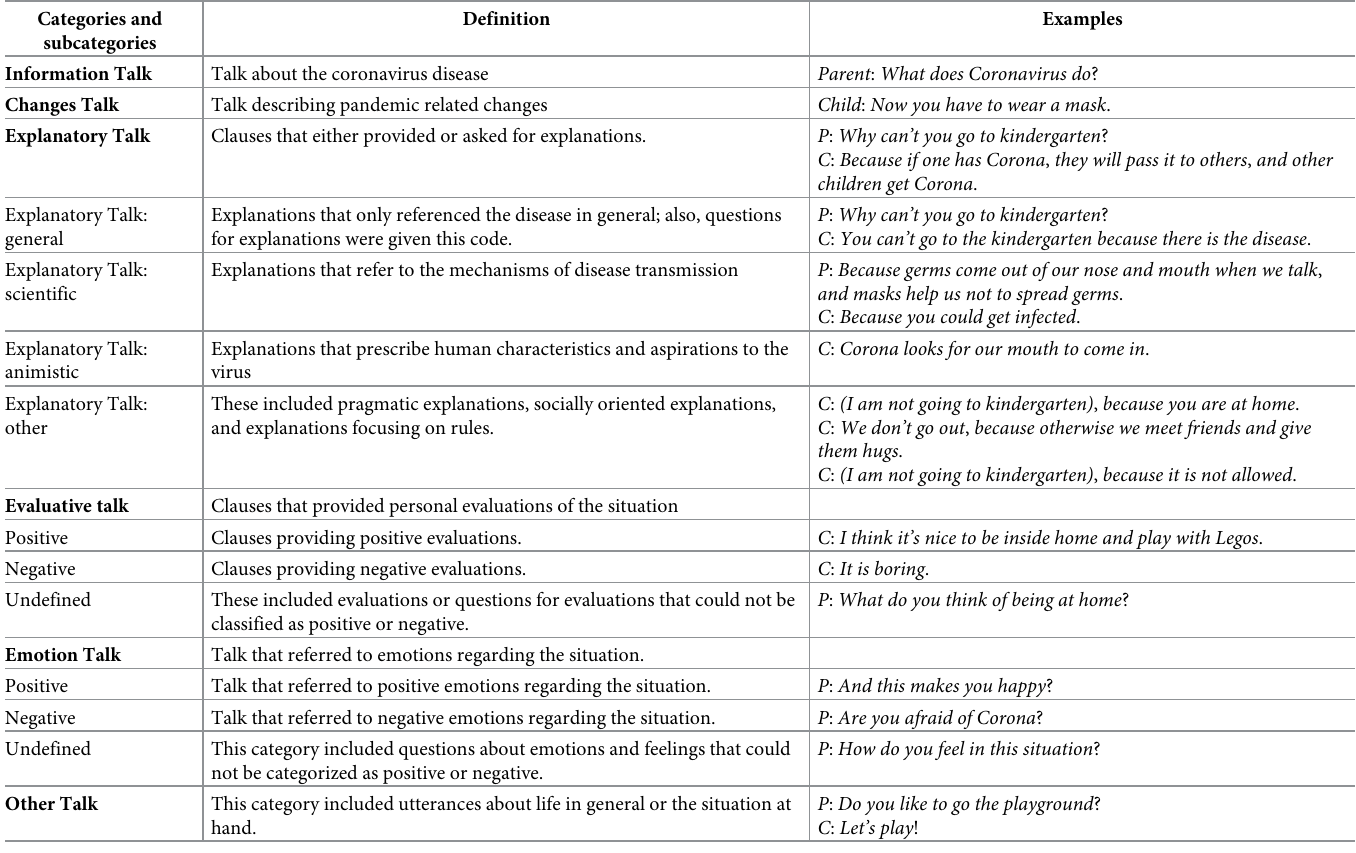
Table 2. Coding categories for parent-child